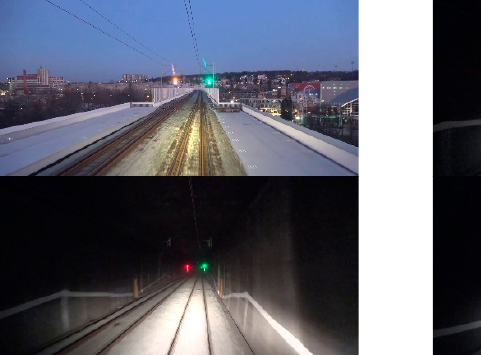
Figure 10. Selected examples of night images plus tunnel (closer than 25 m from the camera). Adapted with permission from [32].